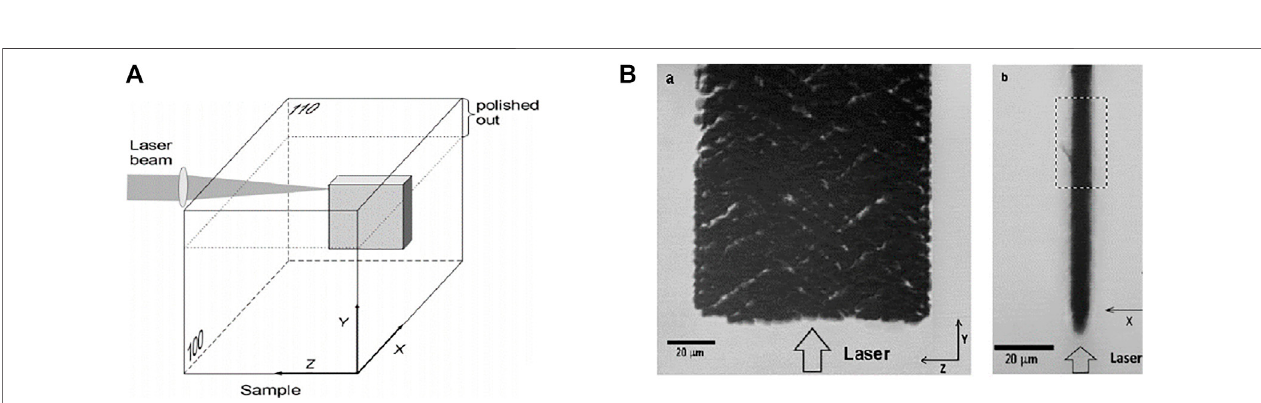
FIGURE 7 | (A) Microstructuring of diamond bulk with femtosecond laser pulses, (B) transmission optical micrographs of side view of the modi fi ed region [50].